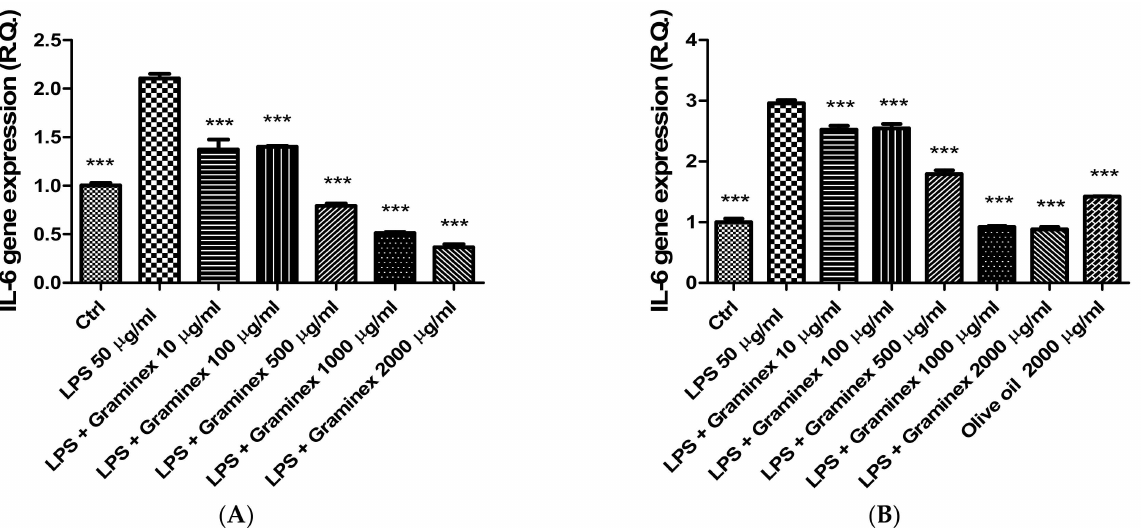
Figure 4. Inhibitory effects of the hydroalcoholic extract (10–2000 µ g/mL) on IL-6 gene expression in isolated prostate ( A ) and ovary ( B ) specimens. ANOVA, p < 0.0001; *** p < 0.001 vs. ctrl group.